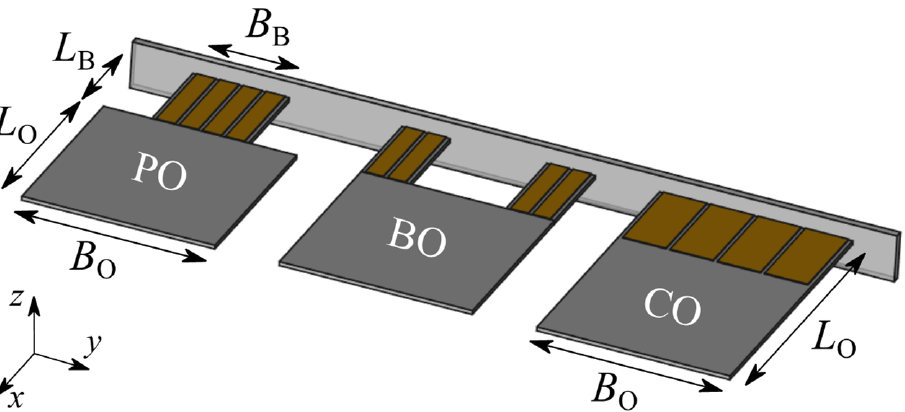
Figure 1. Schematic 3D view on the investigated MEMS oscillator structures. From left to right: pad- dle oscillator PO, bending oscillator BO, and cantilever oscillator CO. The oscillators with thickness T are actuated with piezoelectric AlN elements, which are covered with gold electrodes. Microscope images of the fabricated micro-oscillators can be found in Appendix A.